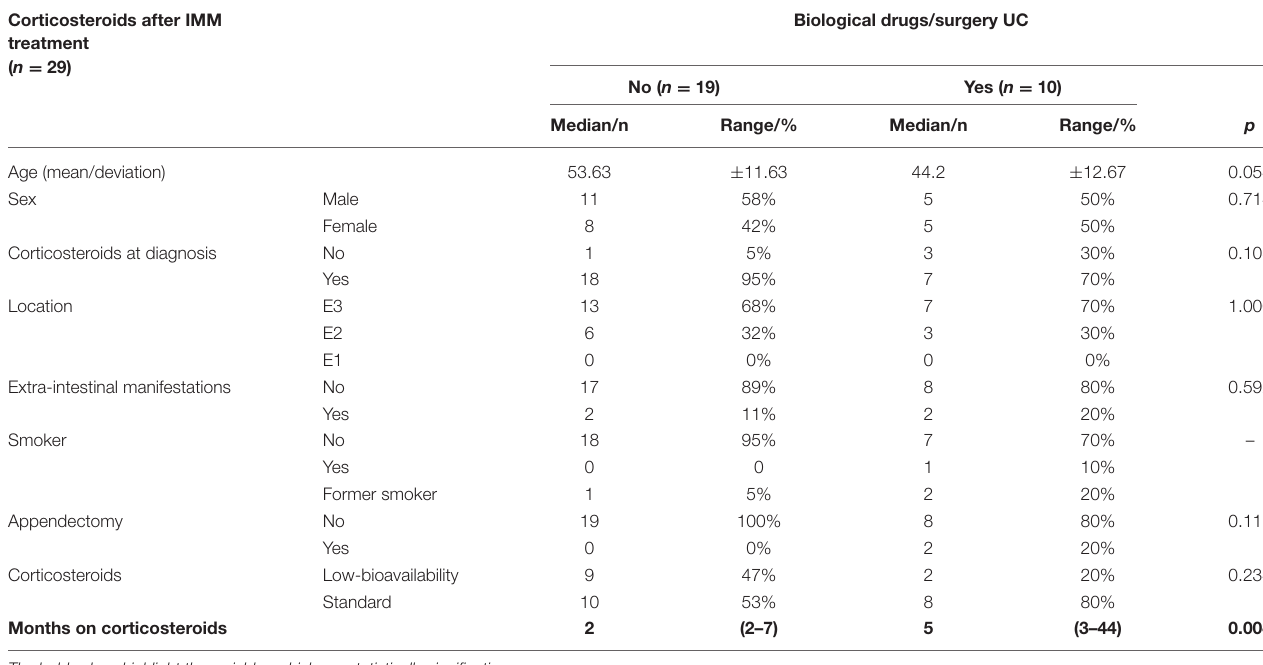
TABLE 4 | Requirement for rescue therapy with biological drugs/surgery in immunosuppressed patients with UC who have needed treatment with corticosteroids. Corticosteroids after IMM treatment